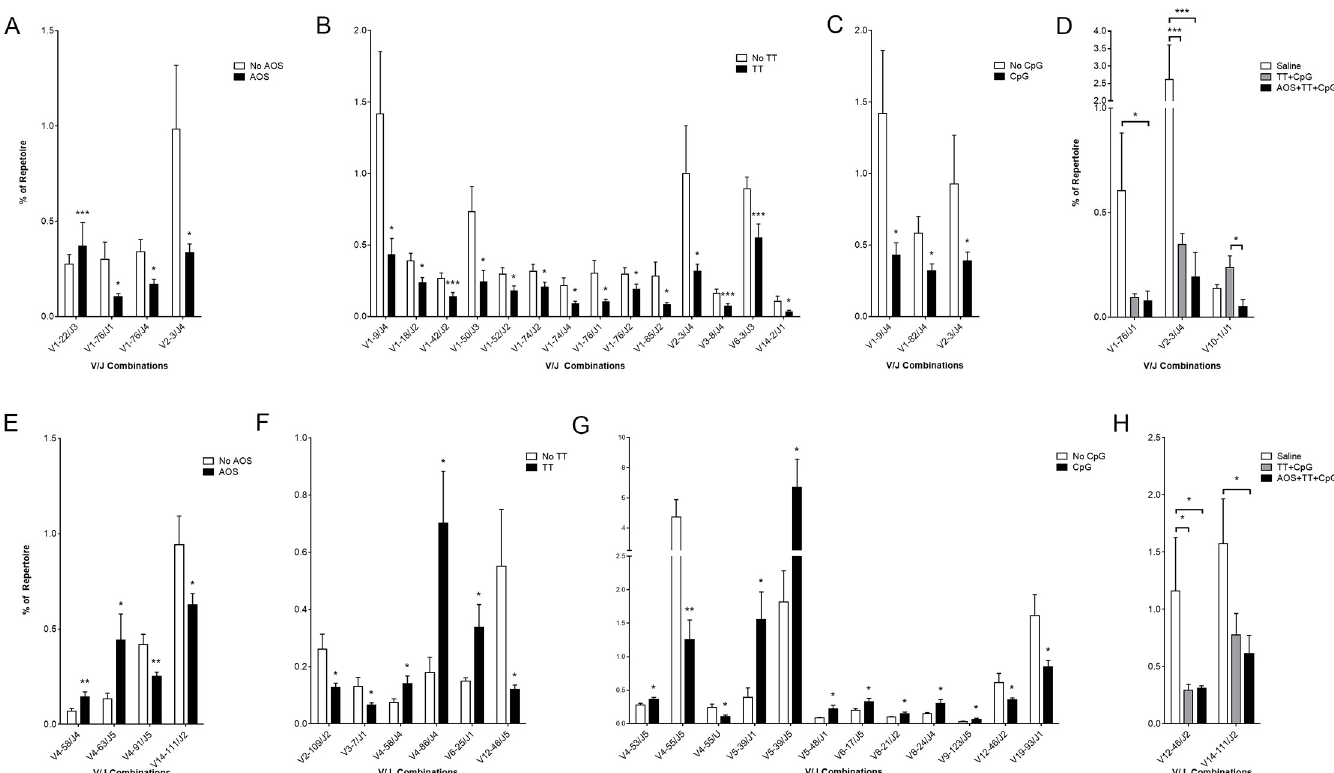
Fig 10. Impact of AOS, Tetanus Toxoid, and/or CpG on Splenic B cell V/J Pairing in Heavy (A-D) and Kappa (E-H) Chain. Mice subjected to one or more treatment variables: Significantly different VH-/JH-gene segment pairing by main effect for AOS (A), TT (B), and CpG (C). (D) Significantly different VH-/JH-gene segment pairing in saline, TT+CpG, and AOS+TT+CpG treatment groups. Significantly different V κ -/J κ -genesegment pairing by main effect for AOS (E), TT (F), and CpG (G). (H) Significantly different V κ -/J κ -genesegment pairing in saline, TT+CpG, and AOS+TT+CpG treatment groups. � = P < 0.05, �� = P < 0.01, ��� = P <